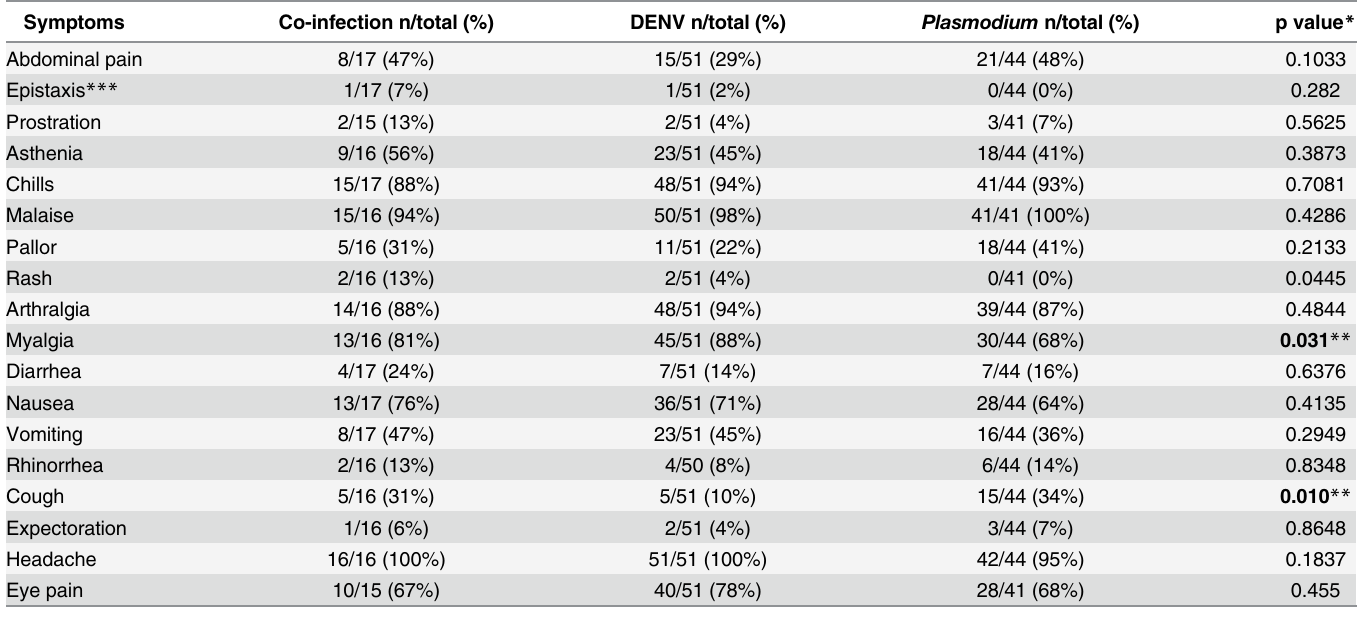
Table 3. Symptom frequency in subjects with co-infection, dengue virus (DENV) mono-infection, and Plasmodium mono-infection.